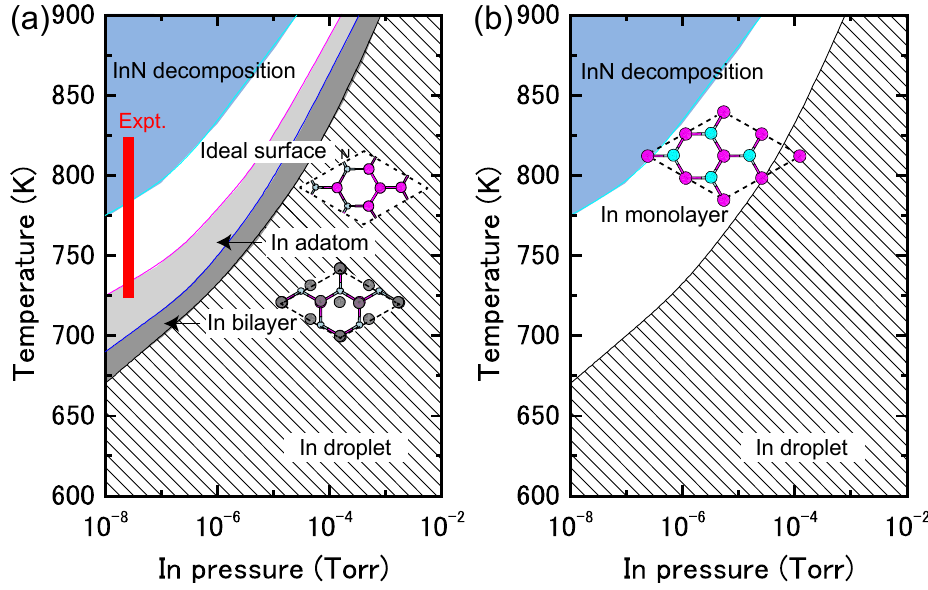
Figure 18. Calculated phase diagrams for polar InN surfaces with ( a ) (0001) and _ ( b ) (0001 ) orientations as a function of temperature and In BEP. The surface stable reconstructions are also schematically